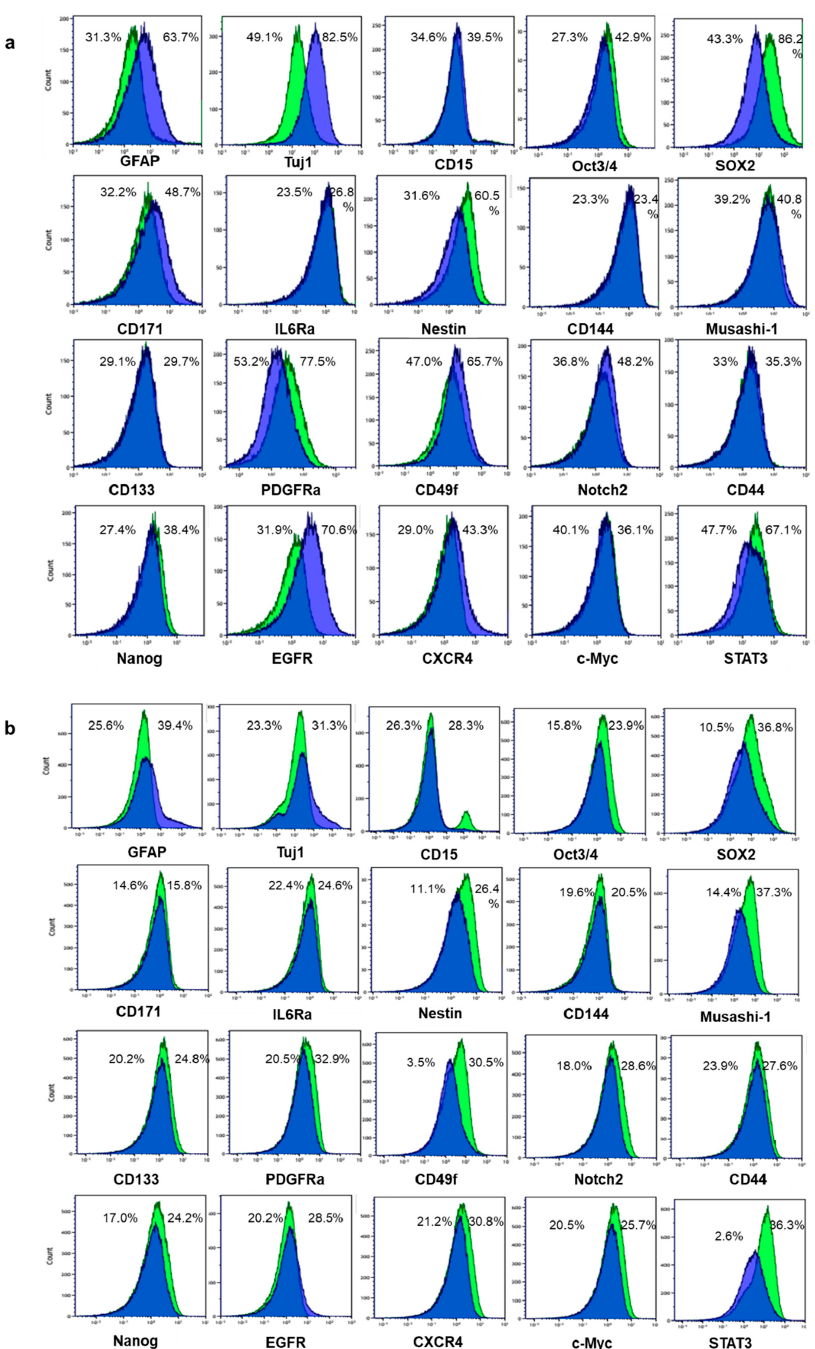
Figure 1. Di ff erentiation was induced in patient-derived glioma stem-like cells (GSLCs) no. 1 ( a ) and no. 2 ( b ) by fetal bovine serum. Green histograms: GSLCs; blue histograms: di ff erentiated cells. Changes in di ff erentiation markers glial fibrillary acidic protein (GFAP) and neuron-specific beta-III tubulin (Tuj1) and stem cell markers are shown. Percentages of the positive cells for each indicated marker are